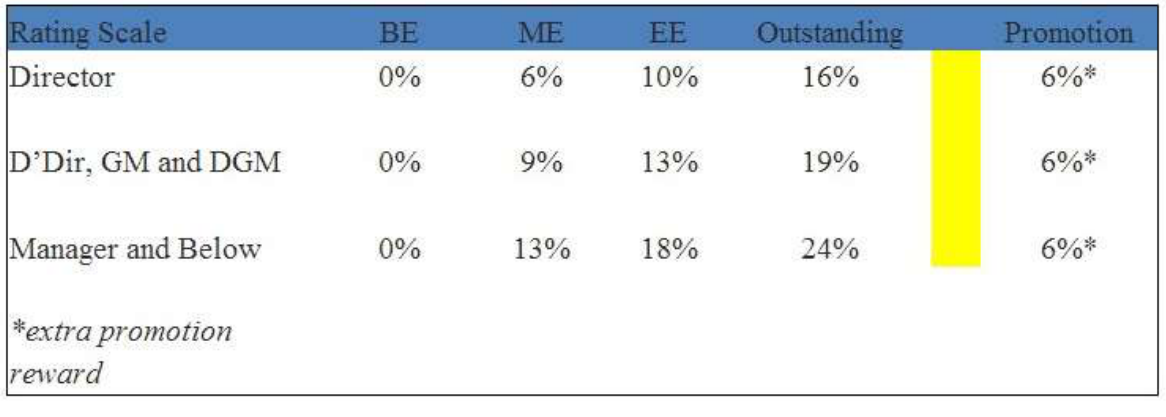
Figure 3: Increment Matrix *Source: Taken from APA-2011 K.E.S.C.